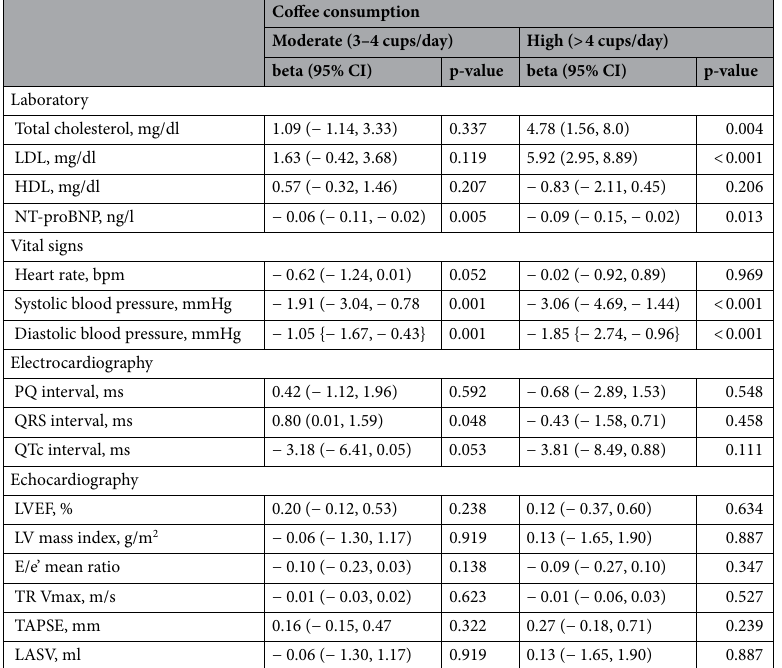
Table 2. Linear regression analysis of laboratories as well as echocardiographic and electrocardiographic parameters with moderate and high coffee consumption. Mild coffee consumption (< 3 cups/day) served as a reference. Adjustment was performed for age, sex, BMI, diabetes, arterial hypertension, smoking, and additives. For systolic and diastolic blood pressure no adjustment for arterial hypertension was performed, instead values for treated individuals were imputed by adding 15 mmHg and 10 mmHg respectively to the measured blood pressure. For cholesterol, LDL, and HDL additional adjustment for lipid-lowering drugs was performed. NT-proBNP was transformed with the natural logarithm. Abbreviations as in Table 1: LASV left atrial systolic volume, LVEF left ventricular ejection fraction, TR Vmax peak tricuspid regurgitation velocity; TAPSE tricuspid annular plane systolic excursion, LASV left atrial systolic volume.